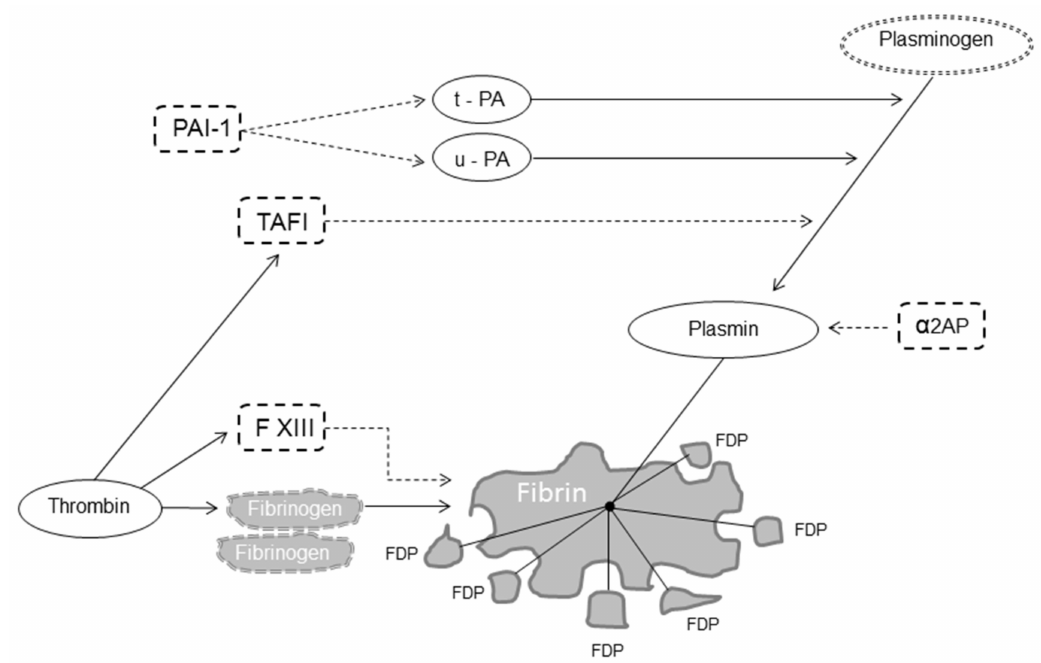
Figure 1. Fibrinolysis. Legend: dot arrow inhibits fibrinolysis; solid line favors fibrinolysis. Abbreviations: FXIII, factor XIII, t-PA, tissue plasminogen activator; u-PA, urokinase plasminogen activator; α 2AP, α 2 -antiplasmin; PAI-1, plasminogen activator inhibitor 1; TAFI, thrombin-activatable fibrinolysis inhibitor; FDP, fibrin degradation products. Table 1. Summary of congenital and acquired hemorrhagic disorders of primary